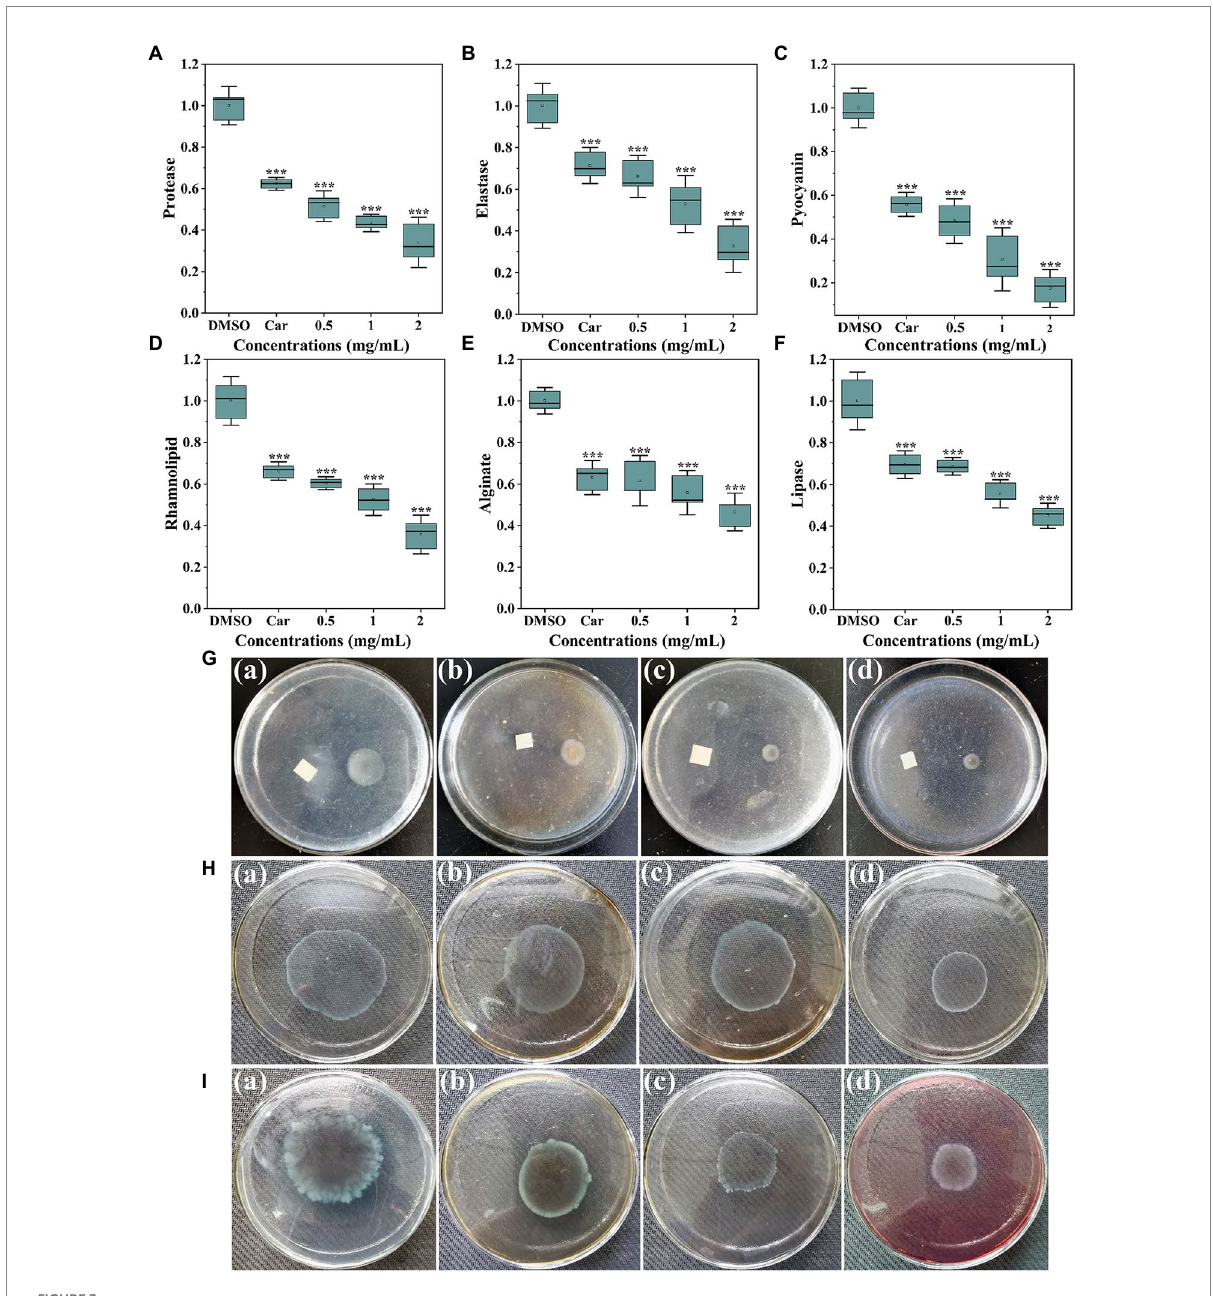
FIGURE 3 Inhibitory effects of thymoquinone on virulence factors production. (A) Protease activity. (B) Elastase activity. (C) Pyocyanin levels. (D) Rhamnolipid levels. (E) Alginate levels. (F) Lipase activity. Carvacrol (Car) and DMSO served as the positive and negative control, respectively. (G-I) represented chemotaxis, swimming motility, and swarming motility, respectively, treated with (a) DMSO, (b) 1 mg/ml of carvacrol, (c) 1 mg/ml of thymoquinone, and (d) 2 mg/ml of thymoquinone. Statistical differences were determined by ANOVA followed by the Tukey–Kramer test. ( ∗∗∗ ) p < 0.001 versus the DMSO